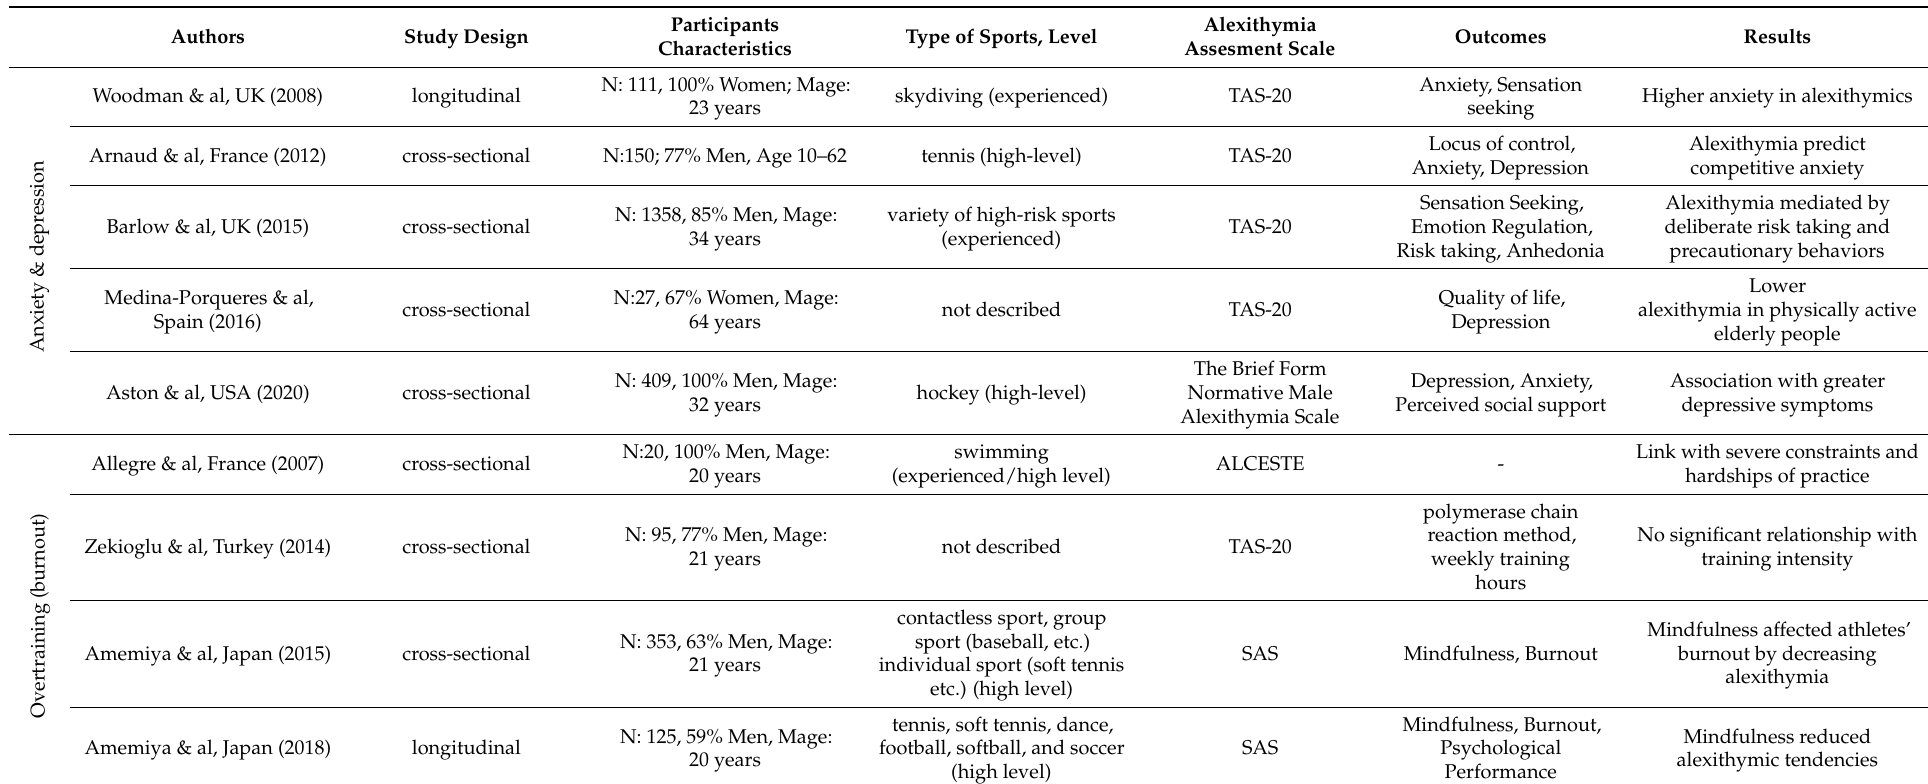
Table 2. Reviewed studies